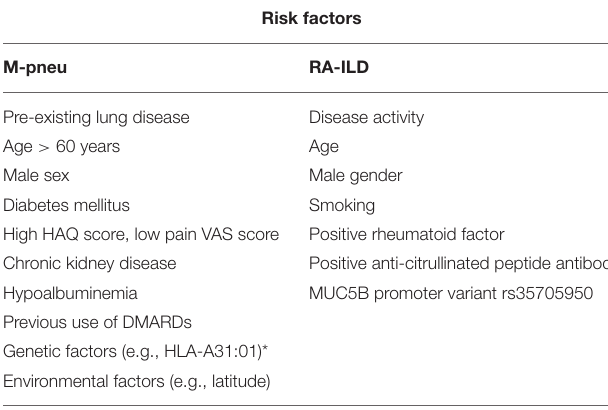
TABLE 1 | Proposed risk factors for the development of methotrexate-associated pneumonitis (M-pneu) and rheumatoid-arthritis-interstitial lung disease